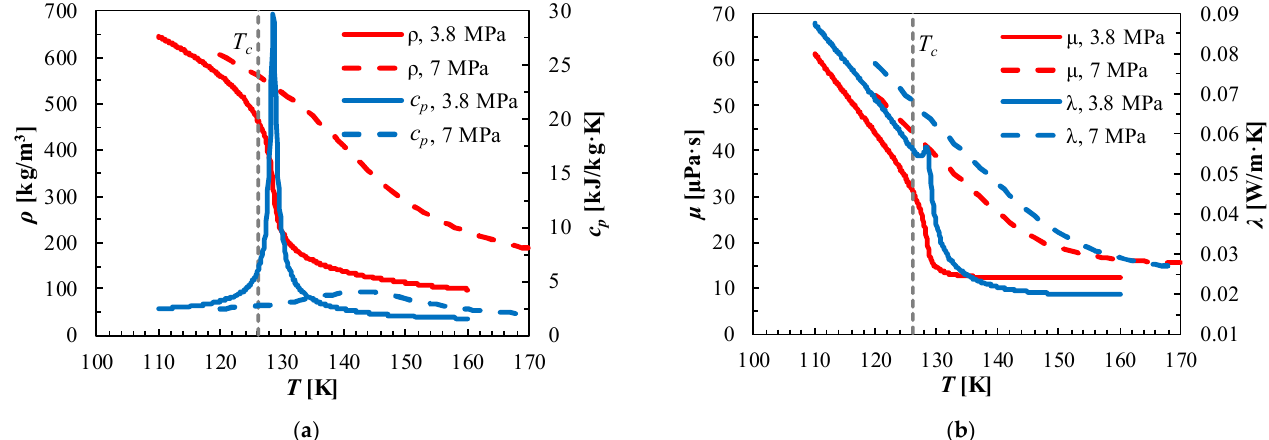
Figure 1. Variations of thermophysical properties of N 2 with temperature: ( a ) density and specific heat capacity; ( b ) viscosity and thermal conductivity [9].